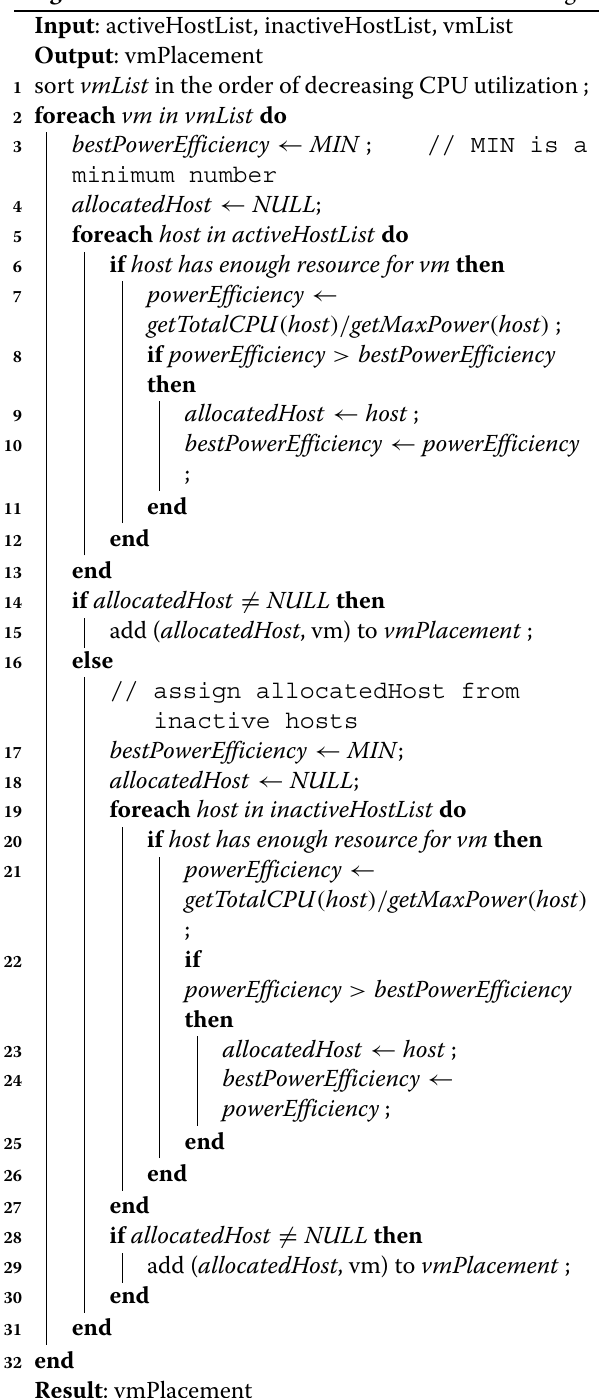
Algorithm 1: The Power Efficient First-Fit